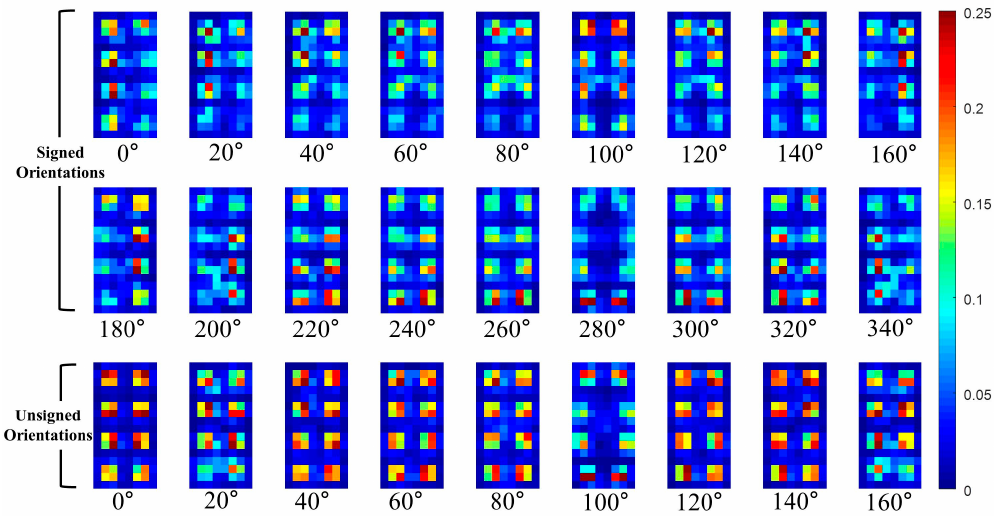
Figure 9. Average of P parts of T π HOG for pedestrians.